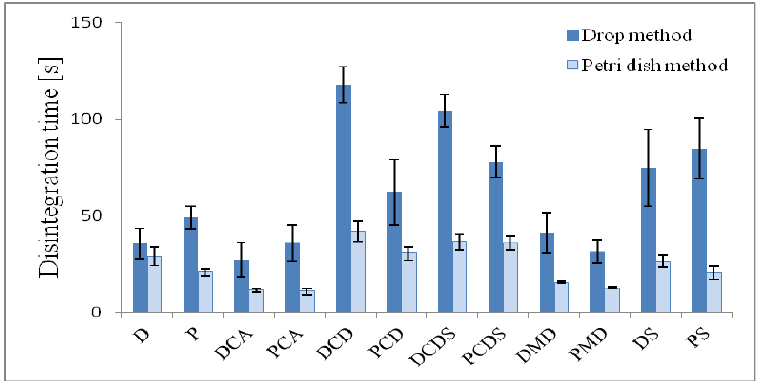
Figure 2. Disintegration times of prepared orodispersible films; n = 3; all values: arithmetic mean ± standard variation.